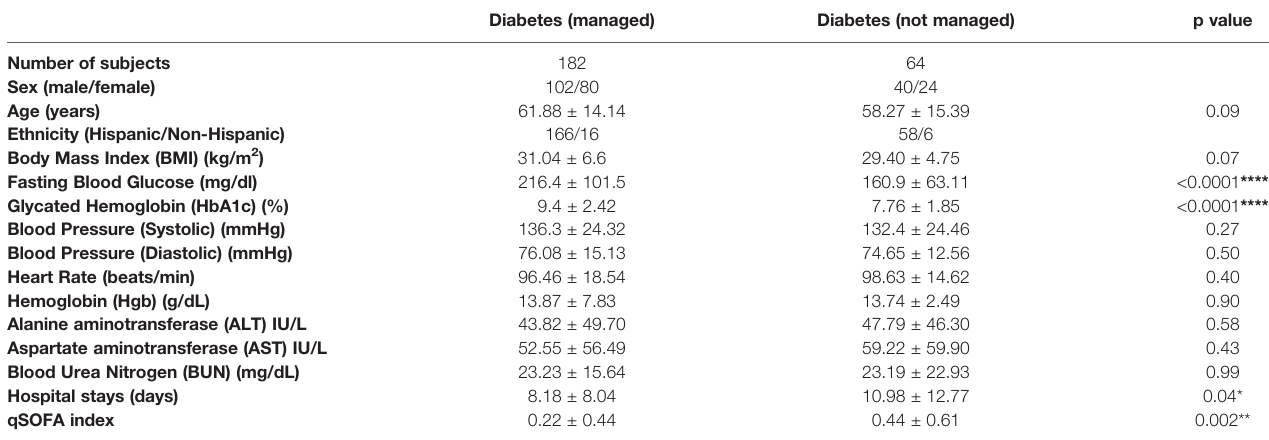
TABLE 2 | Study subject characteristics.